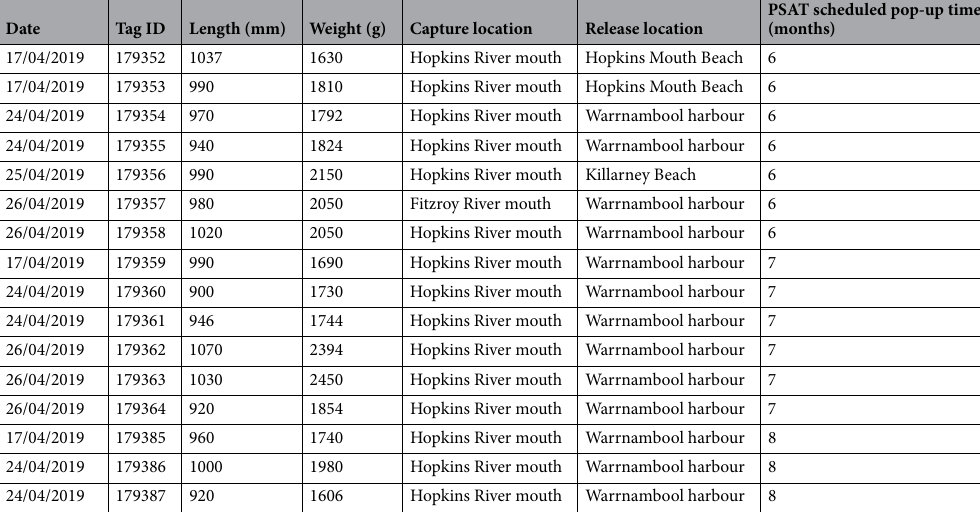
Table 1. Biological data for tagged adult female short-finned eels from south-western Victoria, Australia. All eels were collected as they migrated out of estuarine